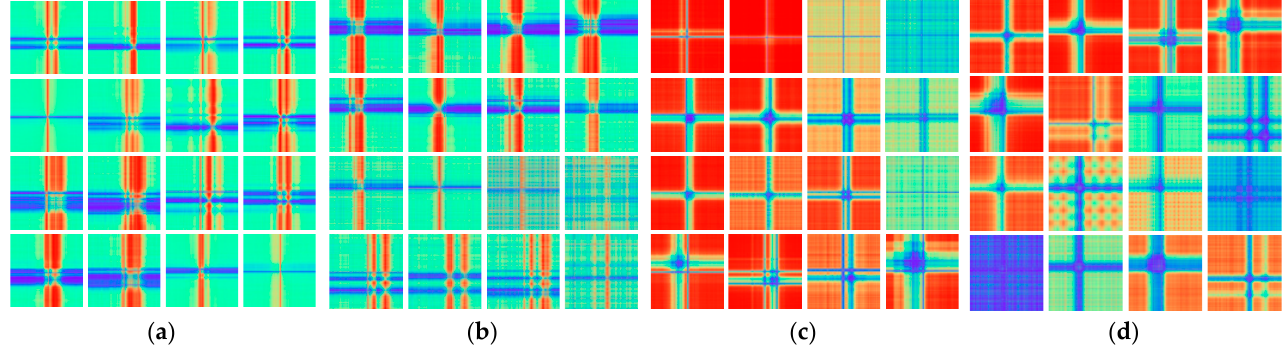
Figure 8. GADF and GASF encoded image samples: ( a ) GADF of sea clutter; ( b ) GADF of target; ( c ) GASF of sea clutter; ( d ) GASF of target.